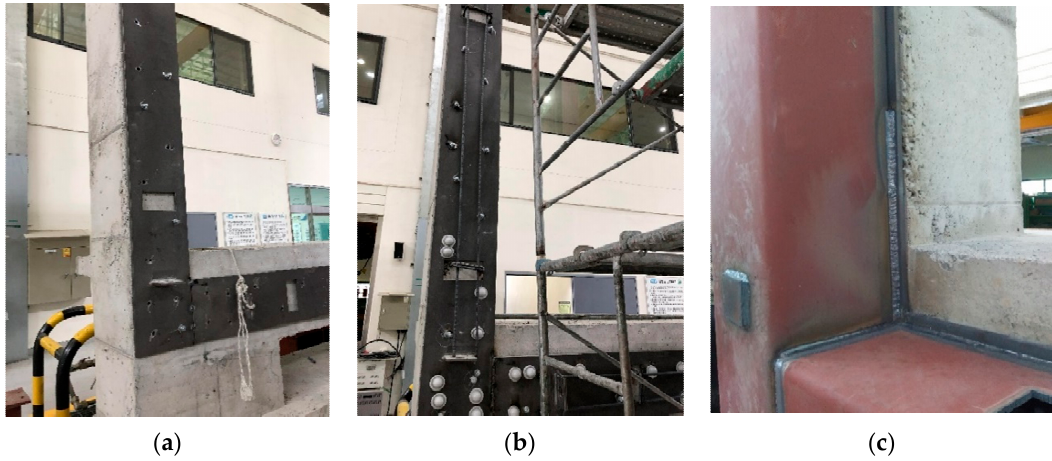
Figure 5. Installation of the CFST frame on the WCFST specimen: ( a ) drilling of holes in the column, ( b ) bonding of base plates using a chemical anchor, and ( c ) welding of base plate and CFST frame.